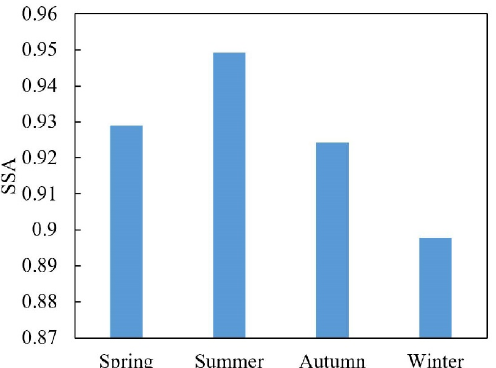
Figure 6. Seasonal distribution of single scattering albedo during the study period.